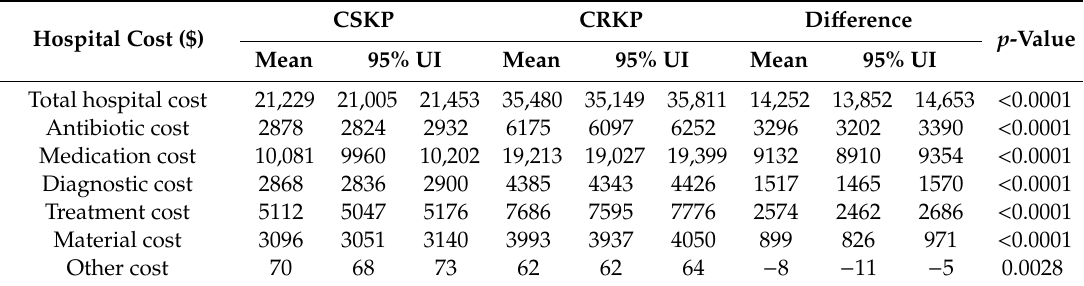
Table 4. Economic costs of patients with CRKP and CSKP after PSM for potential confounding variables.